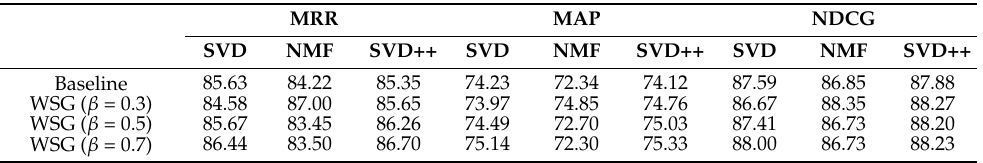
Table 2. MRR, MAP, and NDCG values (%) without and with C-LSTM sentiment and genres-based model on the MARD dataset with different β values.